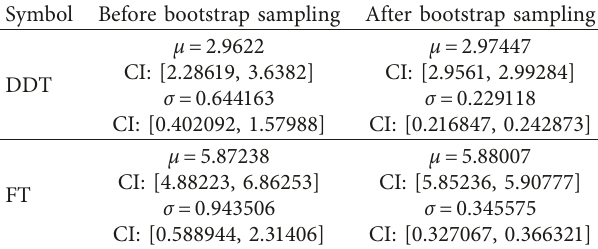
Table 2: The accuracy of the RUL in different